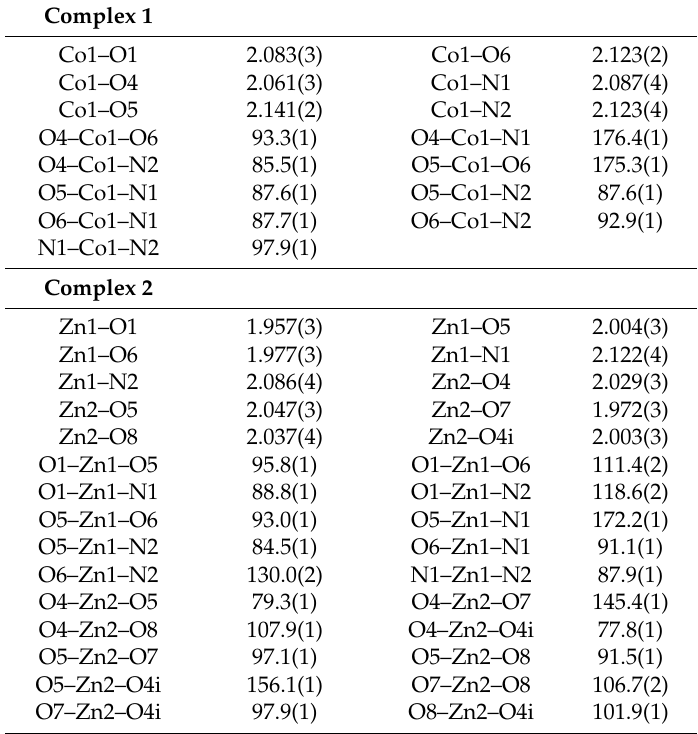
Table 2. Selected bond distances (Å) and bond angles ( ◦ ) for complexes 1 and 2